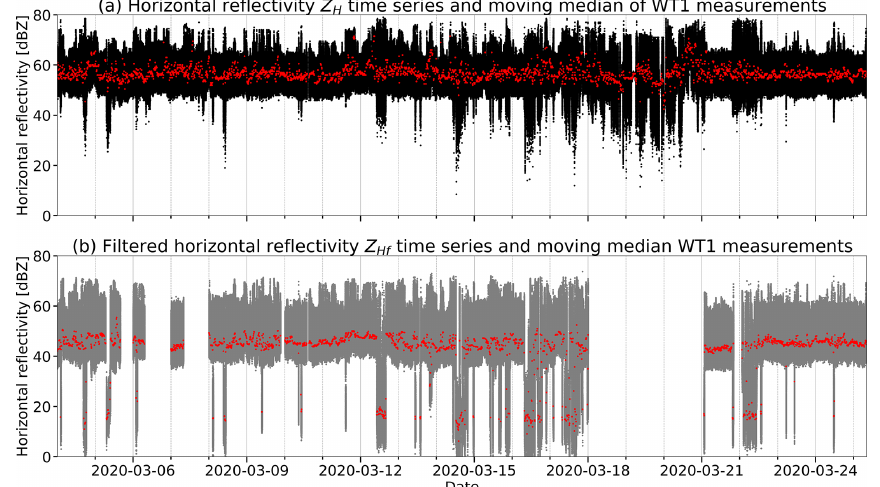
Figure 8. In (a) , the scatterplot time series (black dots) of horizontal reflectivity Z H values retrieved from wind turbine WT1 during the stare- mode measurements of the mobile weather radar in March 2020 (4 to 25 March 2020). The red colored line represents the corresponding moving median of the reflectivity data with a temporal window size of 10min. In (b) , the scatterplot time series (gray dots) of the clutter notch Doppler-filtered Z Hf values and corresponding moving median. The clutter filter used has a width of 7ms − 1 and was applied during postprocessing to moment data where spectral data were available. In consequence, gaps appear in the time series of Z Hf .